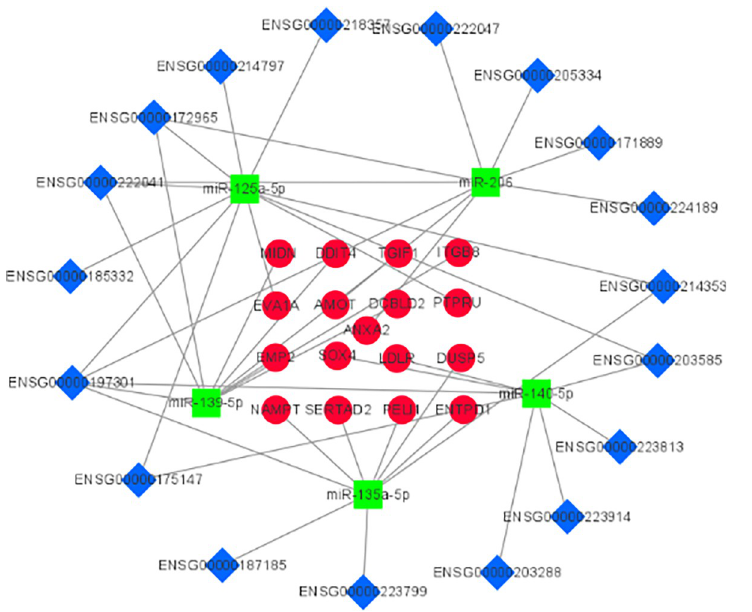
Fig 6. The interaction diagram of the ceRNA network.